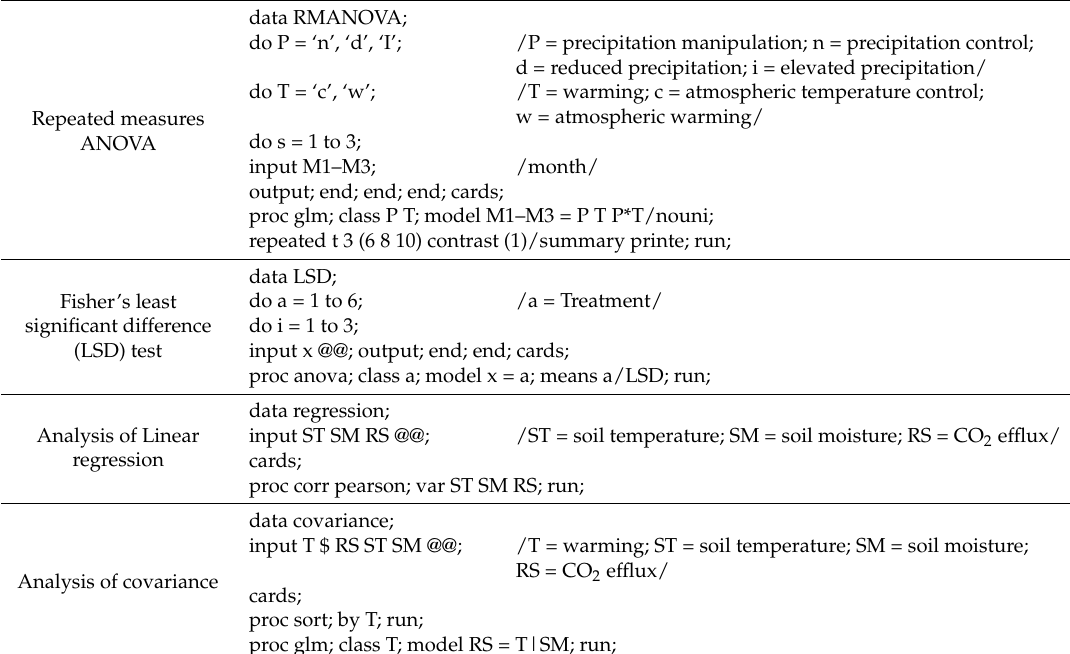
Table A2. The code of statistical analysis performed with SAS v.9.3 (SAS Systems, Cary, NC, USA).